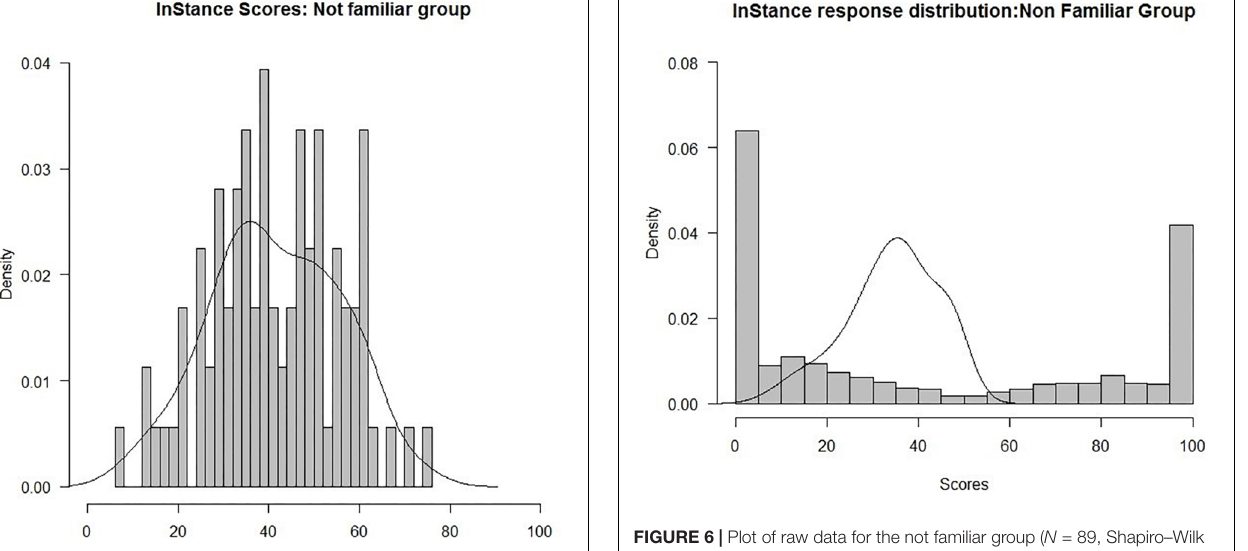
group ( N = 62), whereas participants with an ISS above 50 (50 – 100) were classified as the Mentalistic group ( N =